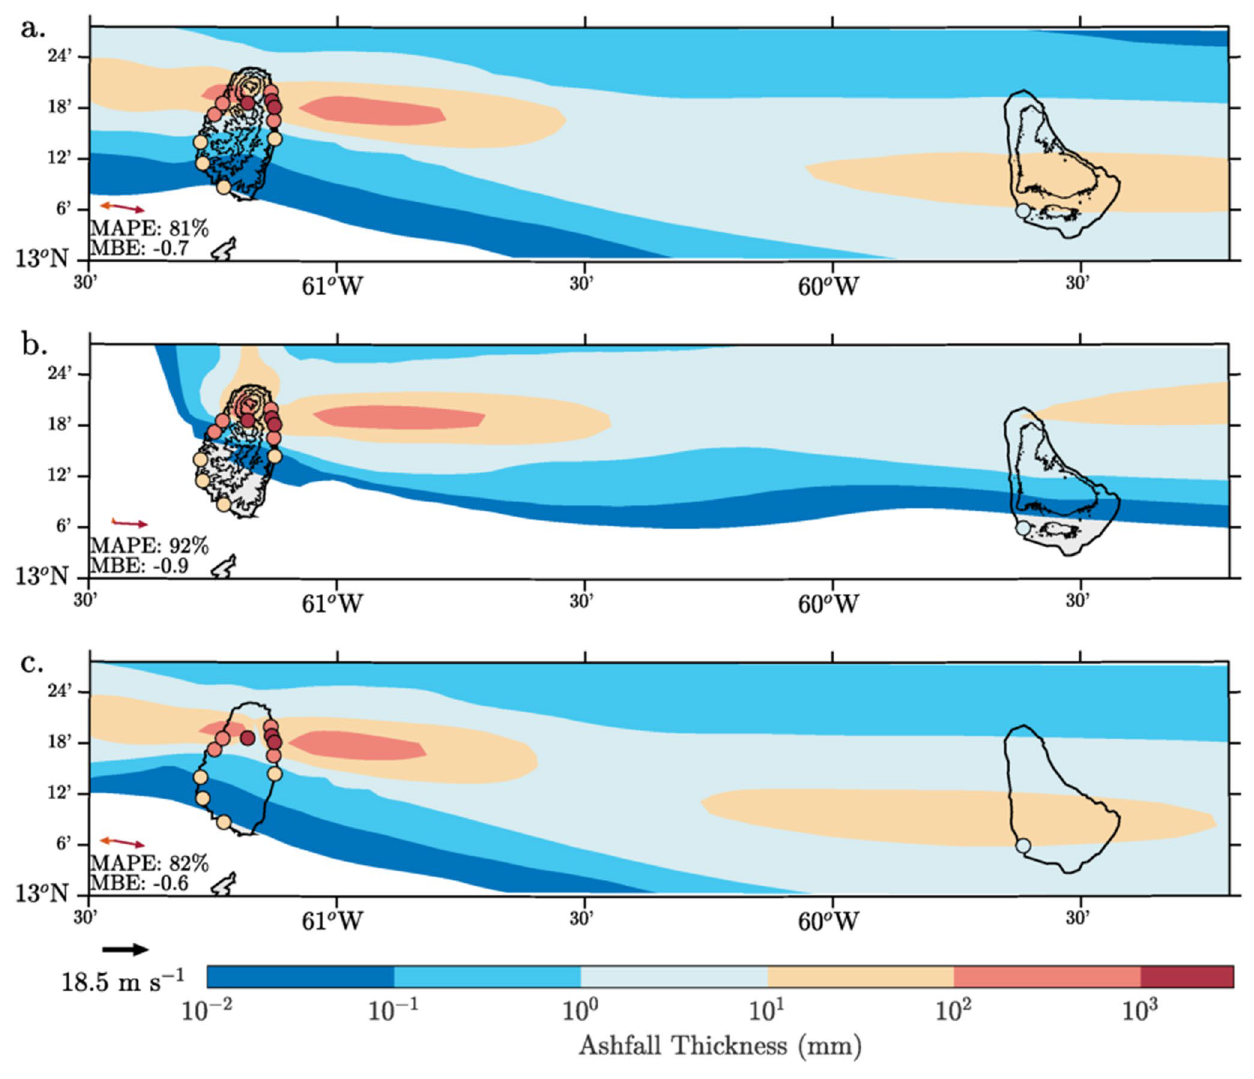
Figure 2. Ash thickness distributions following the 7 May 1902 eruption of Soufriere St Vincent. Simulated from the meteorological-ash-dispersion model where the experiments are ( a ) Control; ( b ) Alternative Wind profile; and ( c ) Flat Topography. Ash thickness observations are plotted over the contours using filled circle markers. Note the ash thickness scale is logarithmic. Topographic contours are shown at 100 m and every 300 m after that. Domain-averaged wind vectors at 100 m (orange) and averaged between 6–12 km (dark red) are shown in the bottom left corner. A deposit density of 1200 kg m − 3 was assumed to convert model ash fall to ash thickness. Topography contours are shown at 100 m and for every 300 m after that. Plotted using MATLAB Release 2016b, The MathWorks, Inc., Natick, Massachusetts, United